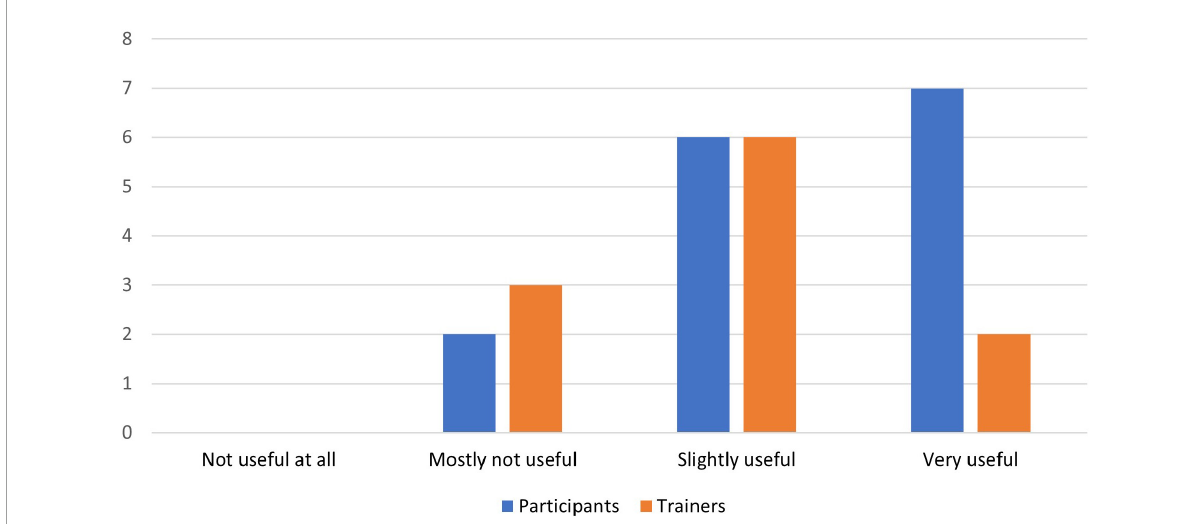
FIGURE4 Feedback on usefulness of the Augmented Reality Games to Enhance Vocational Ability of Patients (REAP) program.